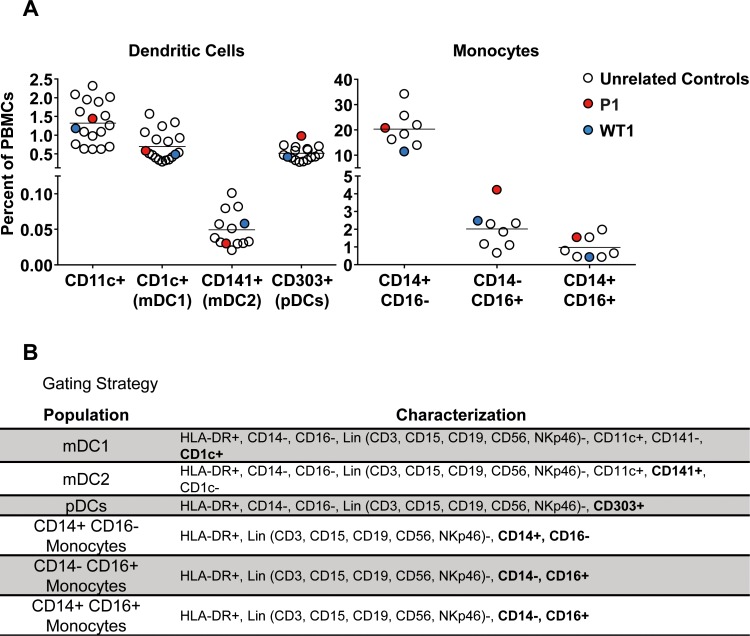
Percentage of dendritic cells and monocyte subtypes within total PBMCs.(A) Percentage of CD11c+, myeloid dendritic cells (mDC1 and mDC2) and plasmacytoid dendritic cells (pDCs) (left), and monocyte subtypes (right) among total PBMCs from healthy unrelated controls, a patient (P1) and a homozygous WT relative (WT1). We showed that the frequencies of these subsets in P1 were similar to those in healthy controls. (B) Gating strategy to define the dendritic cell and monocyte subtypes.